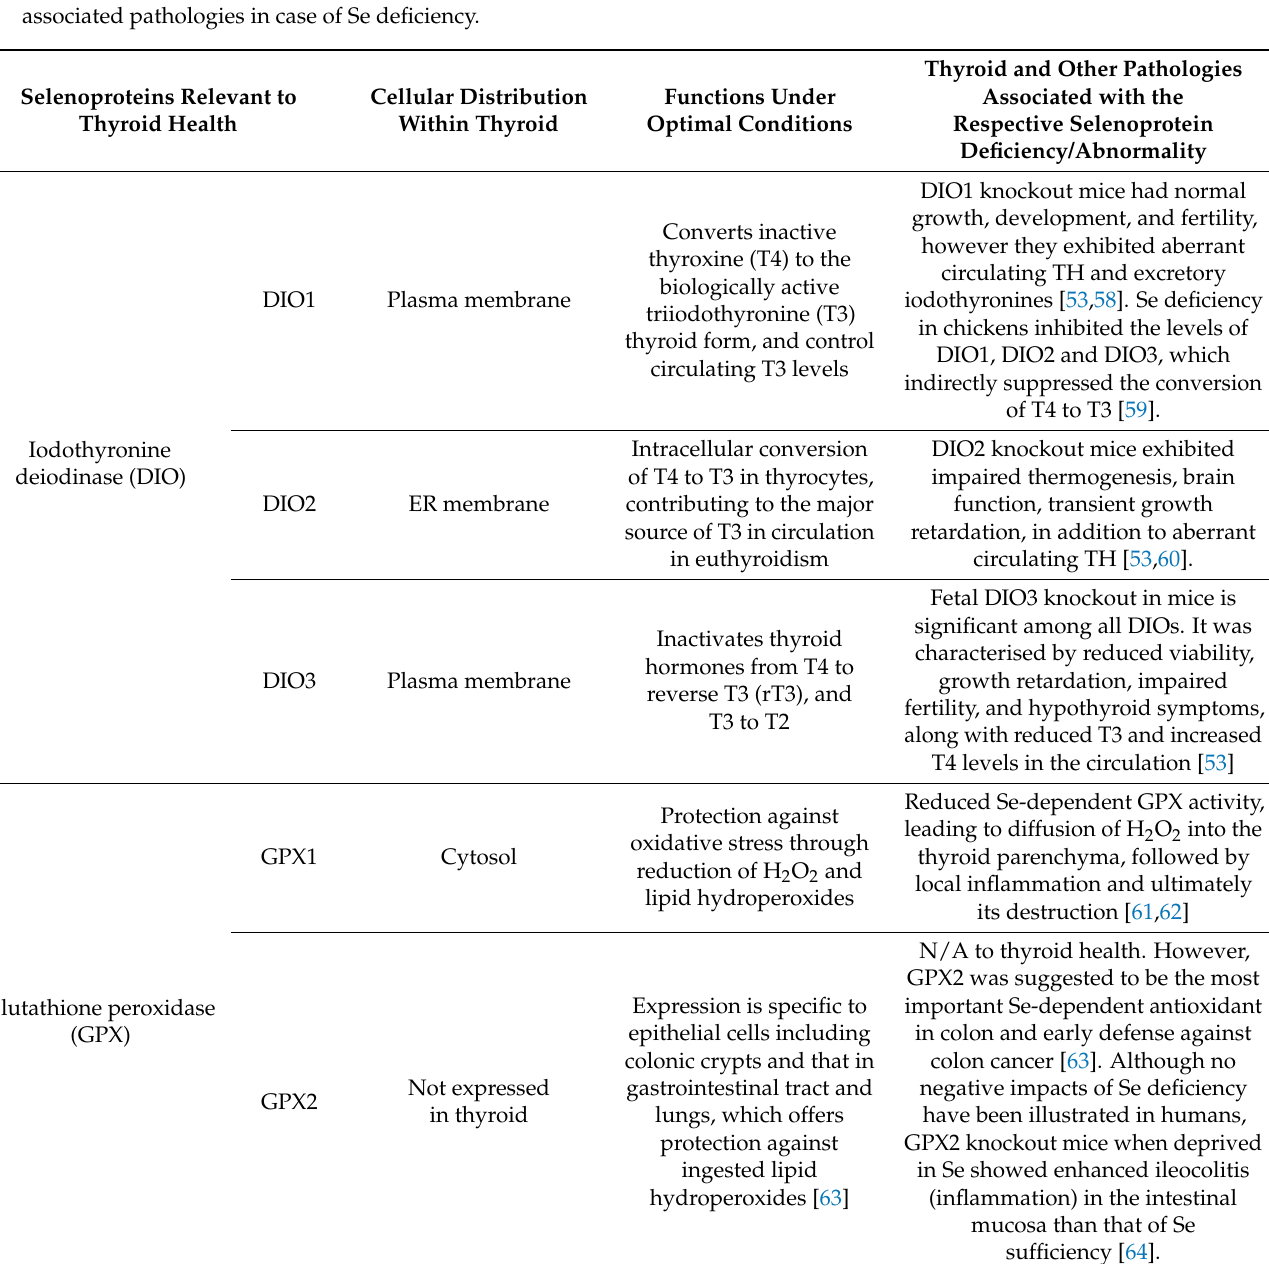
Table 1. Main selenoproteins associated with thyroid hormones functions, antioxidant defense, cellular distribution, and associated pathologies in case of Se